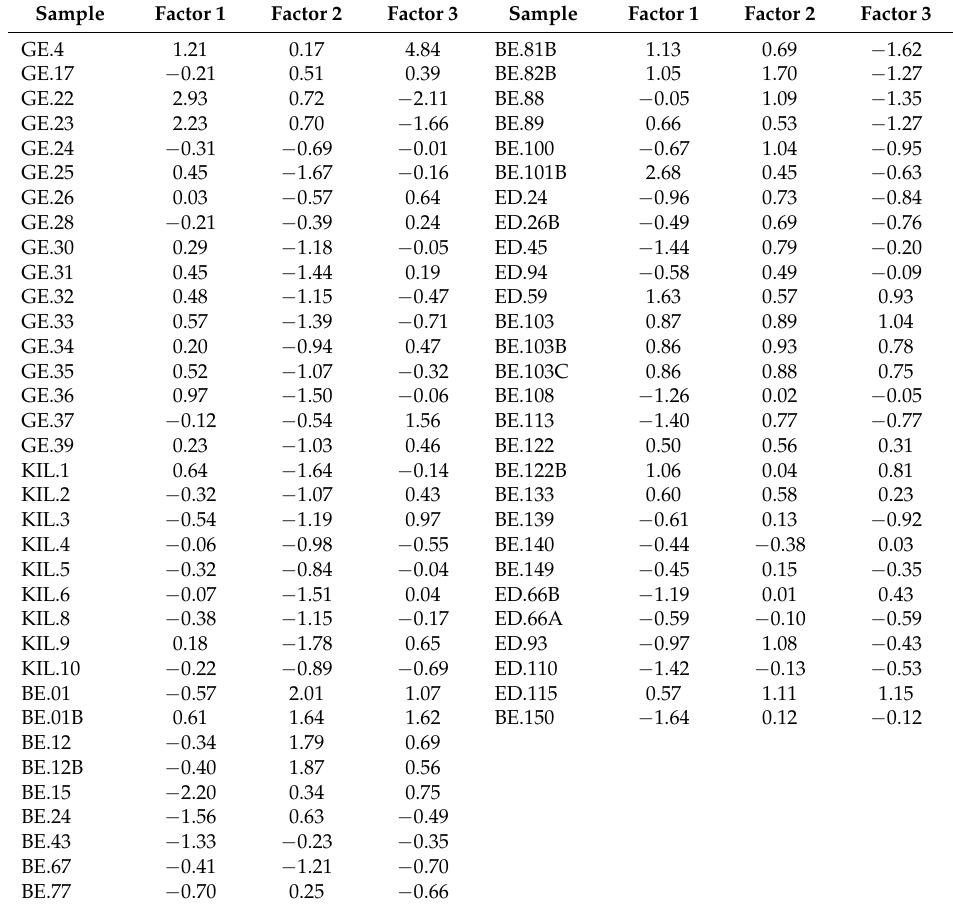
Table 6. R-mode factor analysis: factor scores of the 3-factor